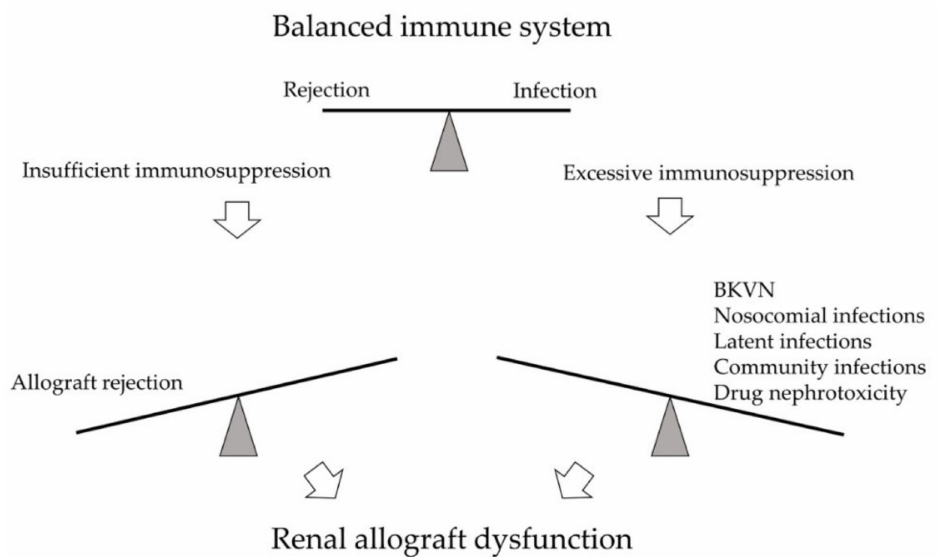
Figure 1. The immune system of kidney transplant recipients is balanced between rejection and infec- tion. Excessive immunosuppression may lead to infections, such as BK polyomavirus nephropathy (BKVN), nosocomial infections, latent infections, and community infections. Drug nephrotoxicity may also develop. On the opposite side, insufficient immunosuppression may result in allograft rejection. Both arms may cause significant kidney damage and renal allograft